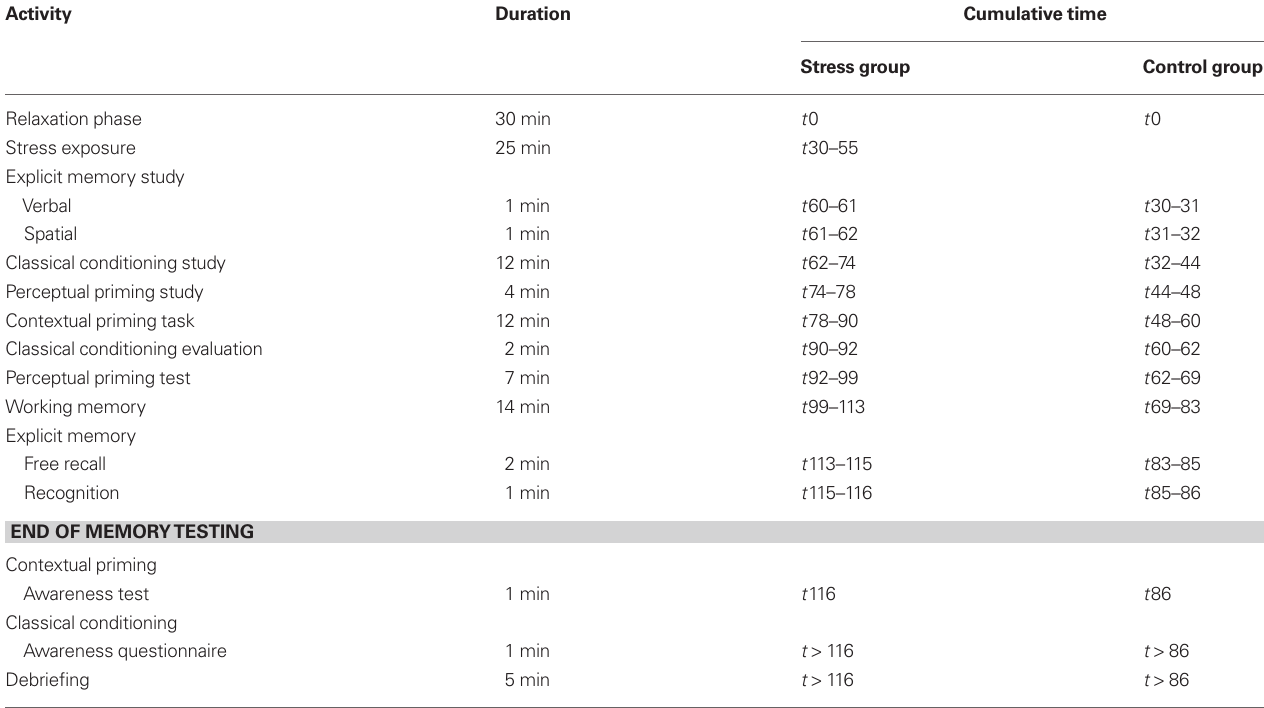
Table 1 | Ordering of tasks and